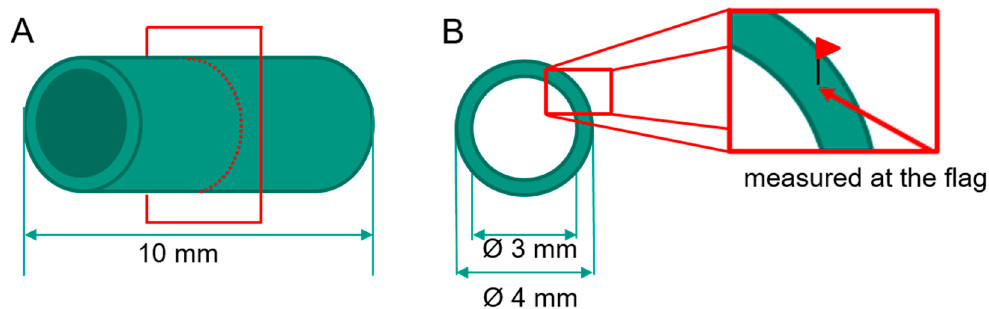
Figure 2. Schematic description of a dilatometer sample, with indication of the cutting plane ( A ) and the position, where the SEM images were taken ( B ).